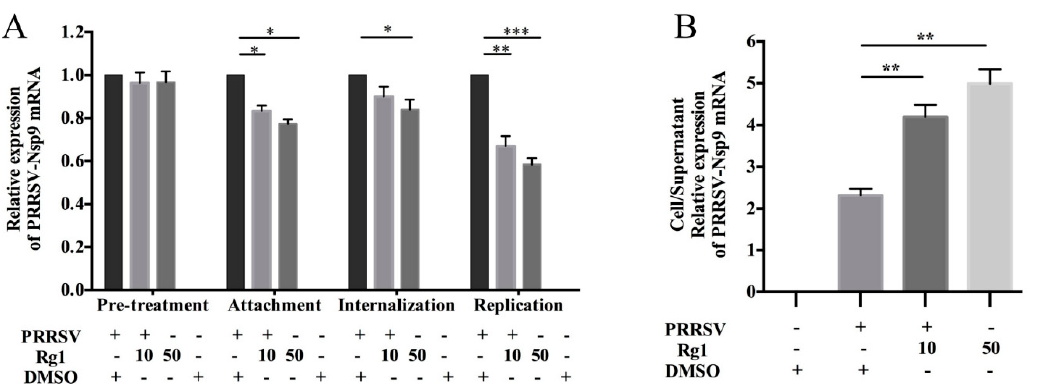
Figure 2. Inhibitory e ff ects on the virus lifecycle of Rg1 in Marc-145 cells. In the Pre-treatment assay, Marc-145 cells were pretreated with DMEM supplemented with 10 or 50 µ M Rg1 for 2 h, then cells were washed twice with PBS before being infected with type 2 PRRSV XH-GD (0.1 MOI), and then samples were collected at 48 h.p.i. For the attachment and internalization assay, Marc-145 cells were pre-cultivated at 4 ◦ C for 1 h and then infected with virus (0.1 MOI) at 4 ◦ C for 2 h. During